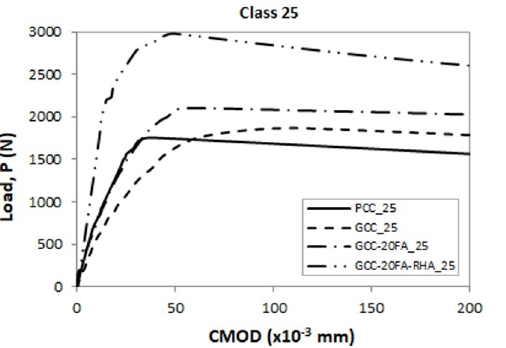
Figure 4. Variation of the stress intensity factor (K extension of the crack (Δ a ) for concrete notched beams of strength class of 25 MPa, with different matrices.